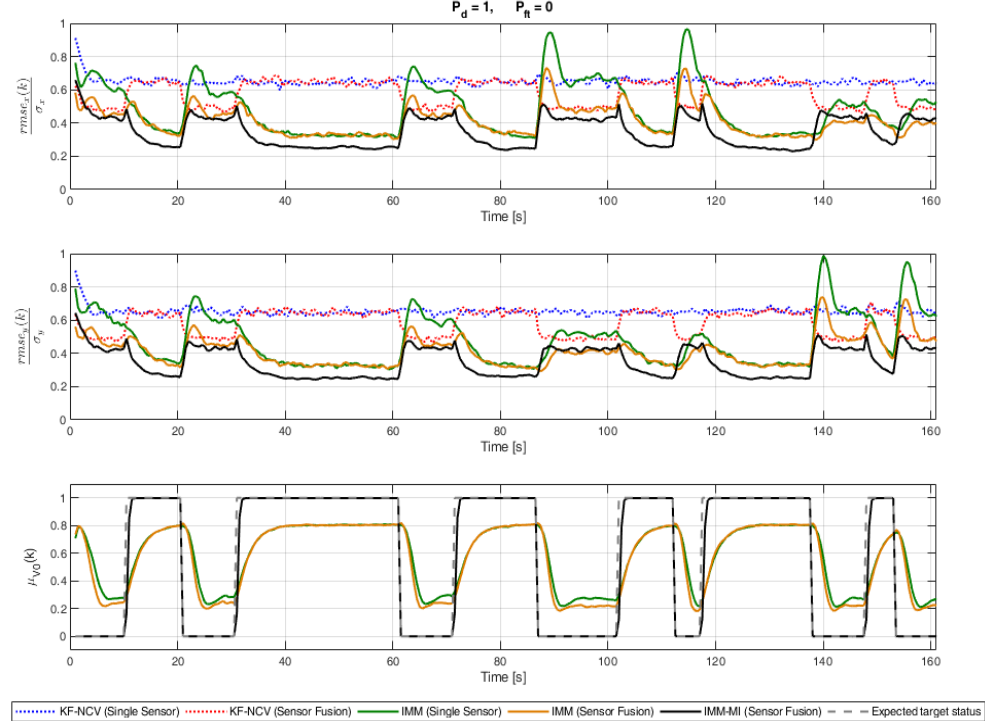
Figure 7. Comparison of the normalized positioning RMSE with respect to the x -axis (top) and the y -axis (center) over a simulated move-stop-move target for P d = 1 and P ft = 0. In the subplot at the bottom is the relative V0 model probabil- ity.